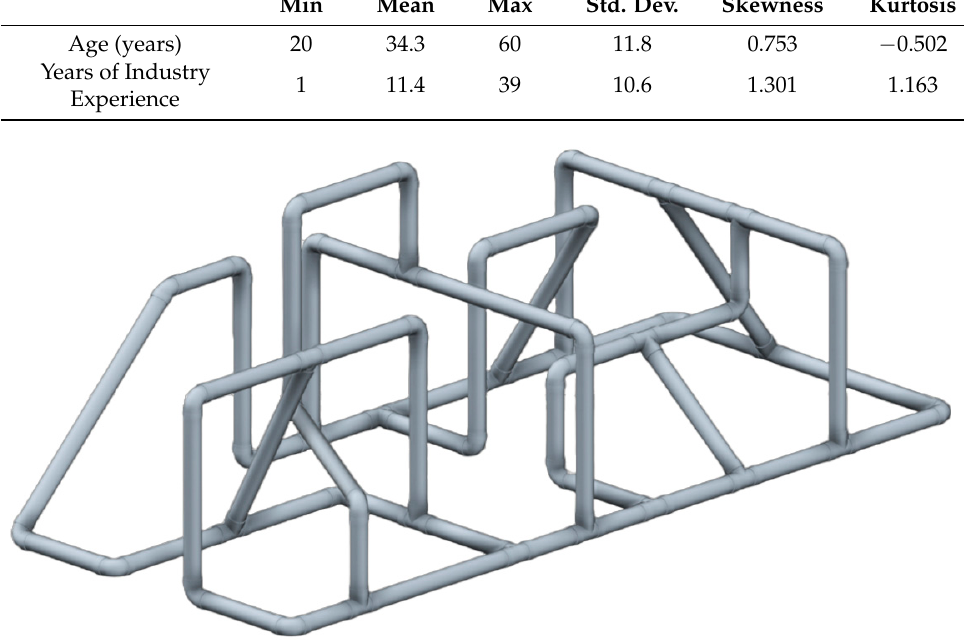
Figure 2. Completed pipe spool assembly model.